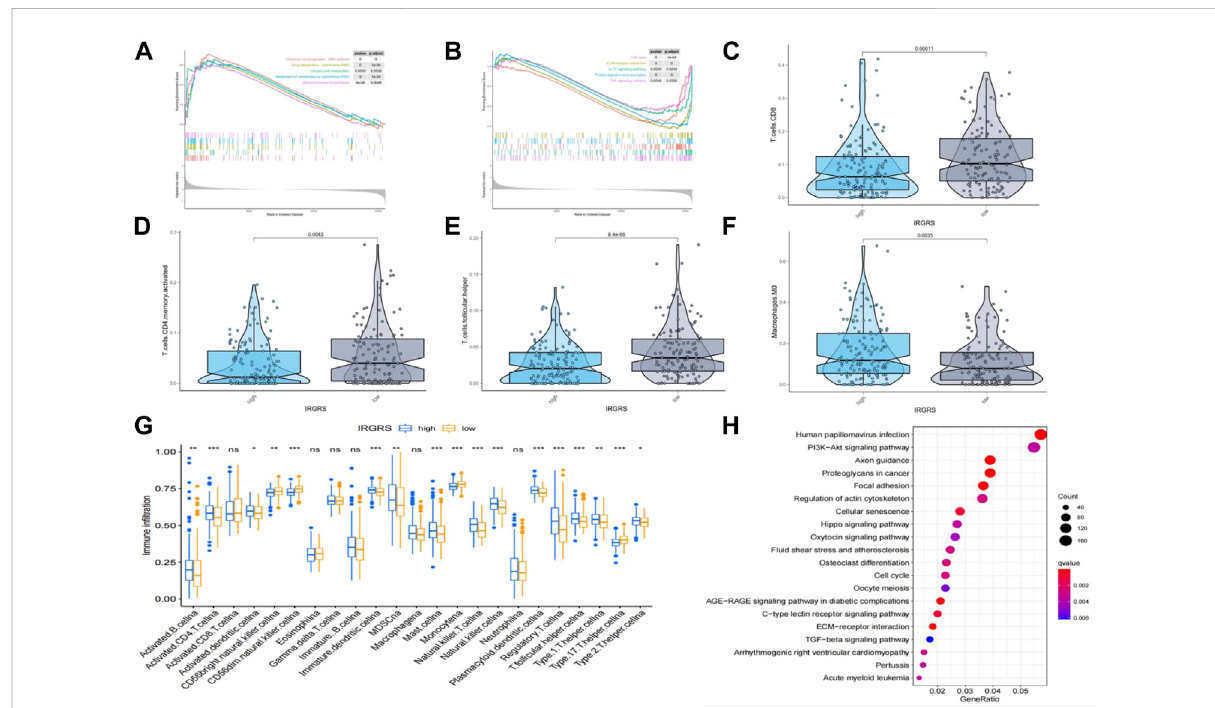
FIGURE 5 Difference in tumor in fi ltrated immune cells between high and low IRGRS groups. (A) . high score pathways enriched by GSEA analysis between highandlowIRGRSgroups. (B) .lowscorepathwaysenrichedbyGSEAanalysisbetweenhighandlowIRGRSgroups. (C – F) .differentkindsofTcellsin tumor environment expressed diffrently between high and low IRGRS groups. (G) . tumor in fi ltrated immune cells analysed by ssGSEA analysis between high and low IRGRS groups. (H) . KEGG analysis of DEGs between high and low IRGRS